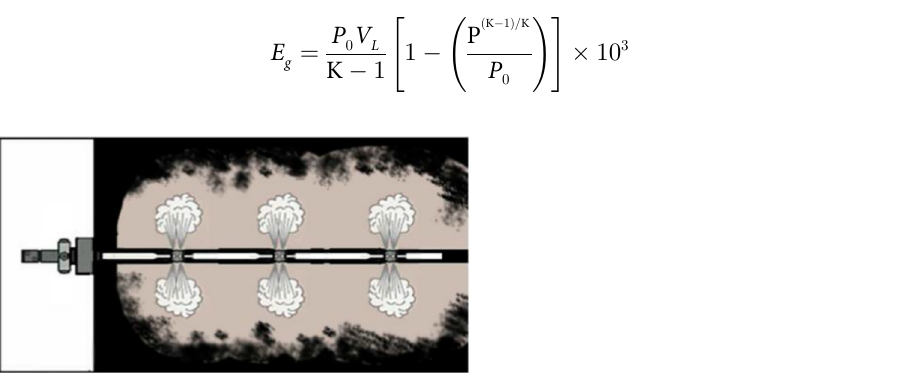
Fig 1. Schematic diagram of phase change fracturing of liquid CO 2